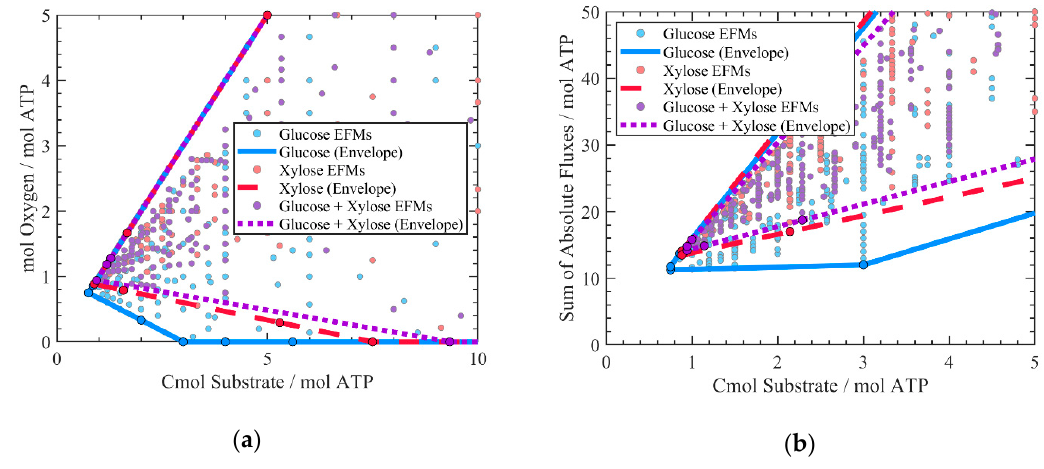
Figure 2. Glucose and xylose co-metabolism (glucose in blue; xylose in red; co-utilization in purple) — ( a ) oxygen cost as a function of carbon substrate cost (moles of oxygen versus moles of carbon consumed in substrate, normalized to moles of ATP generated); ( b ) pathway investment efficiency as a function of carbon substrate cost (sum of absolute fluxes per pathway versus moles of carbon consumed in substrate, normalized to moles of ATP generated). Each point on the plot represents the reaction ratio for an EFM in the simulation; EFMs closer to the origin represent more efficient pathways.